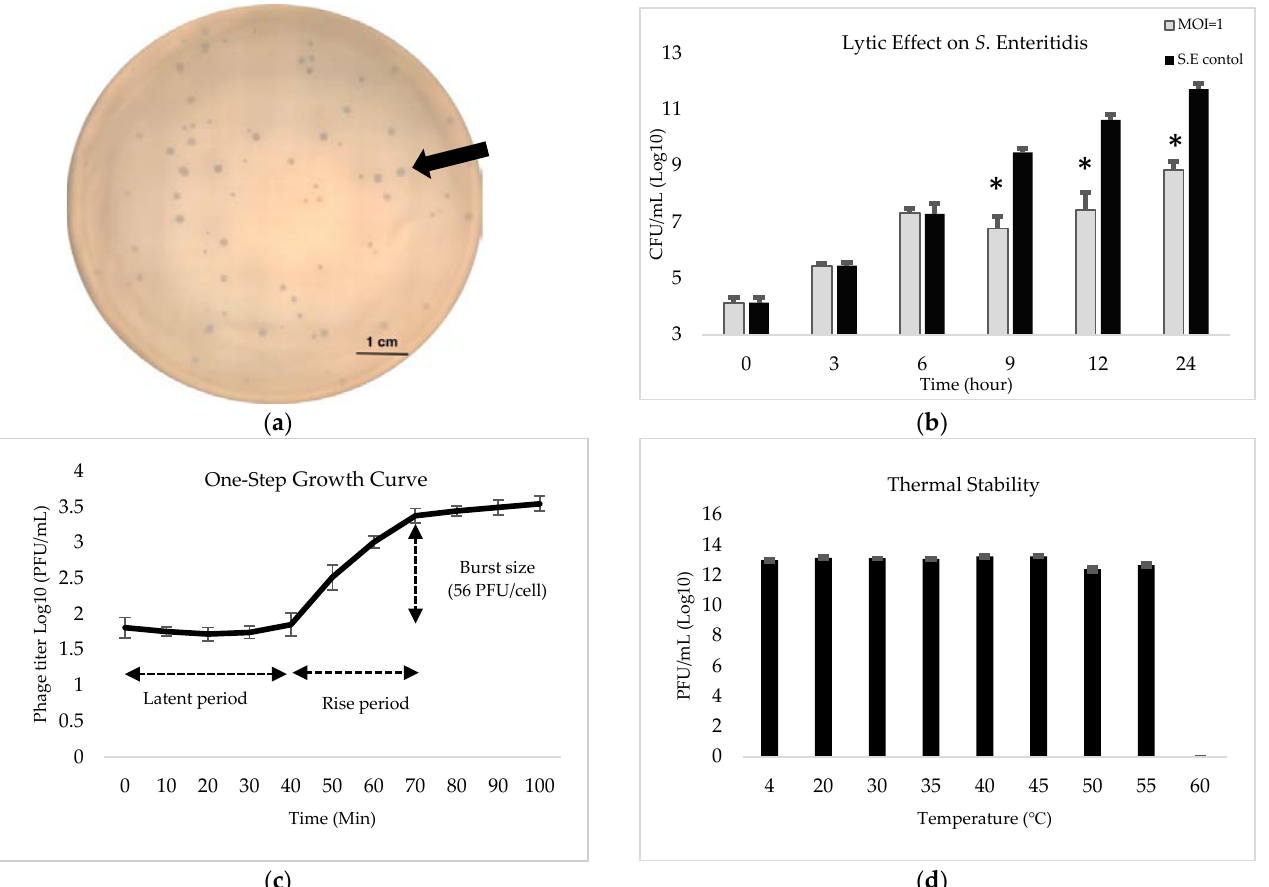
Figure 3. ( a ): Phenotypic and biological characteristics of phage 1252. Phage plaque formed on bi-phasic agar plates when cultured in a lawn of bacterial host cell ( S. Enteritidis). Arrows indicate plaques of different sizes (2.5mm to 0.5mm). ( b ): In vitro lytic activity of phage-1252 in reducing the growth of BHC. The growth of untreated BHC (black) was compared to that inoculated with MOI = 1 of phage-1252 (grey). Error bars indicate the standard deviation from three trials. Significance is indicated by * ( p < 0.05). ( c ): One-step growth curve for measuring titers of phage-1252 across time with BHC as the host when incubated in LB medium at MOI of 0.1. Error bars indicate the standard deviation from three trials. ( d ): Temperature stability of phage-1252 when incubated at increasing temperatures for 1hr.